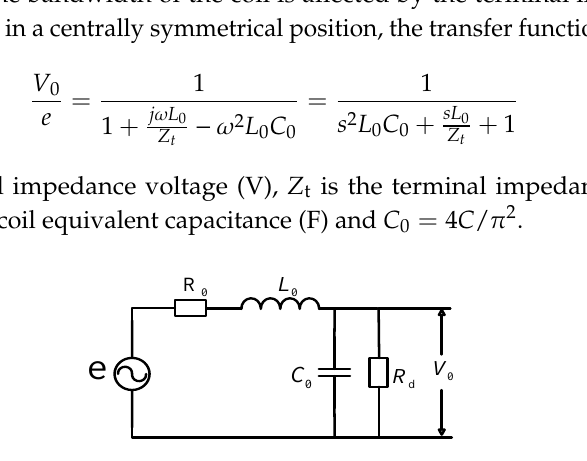
Figure 2. Equivalent circuit of coil termination.